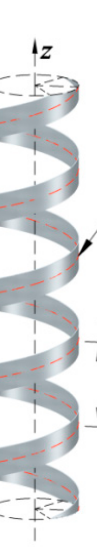
Figure 1. Tape-conductor finite-length helical coil with arbitrary pitch length ( h ).